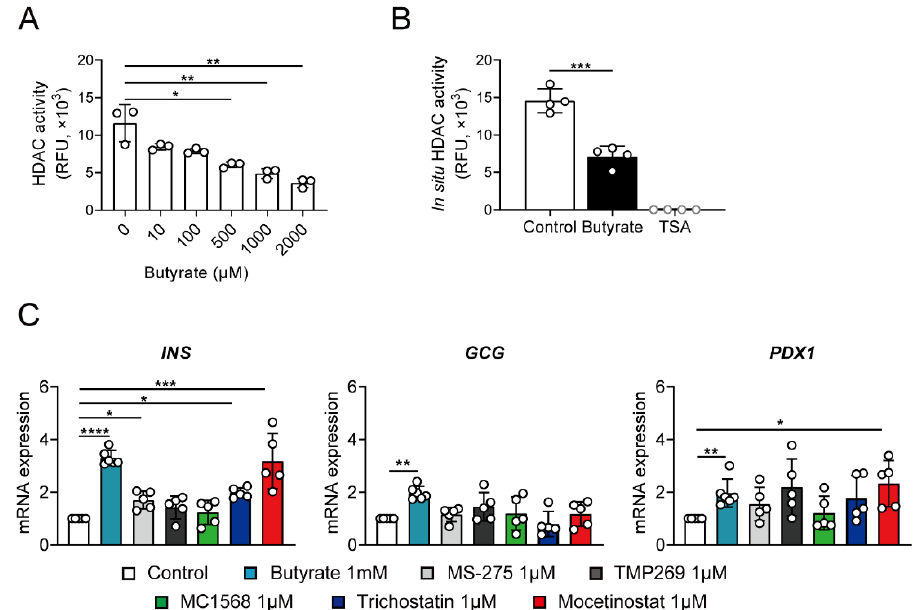
Figure 4. Inhibition of class I HDACs is involved in up-regulation of insulin gene expression. ( A ) Butyrate dose-dependently reduces in vitro HDAC enzyme activity in a HDAC fluorometric assay. ( B ) NPICCs were treated with 1000 µM butyrate and HDAC activity was measured by HDAC Activity Fluorometric Assay. Butyrate (1000 µM) and trichostatin A (TSA, 1 µM) significantly inhibited HDAC enzyme activity. ( C ) NPICCs were treated with different HDAC inhibitors for 6 days. TSA (1 µM) (class I and class II inhibitor), mocetinostat (1 µM) and MS275 (1 µM) (selective class I inhibitors) but not TMP269 (1 µM) or MC1568 (1 µM) (selective class II inhibitors) significantly increased insulin gene expression. NPICCs cultured in B-IC medium were used as controls. Data from three to five independent experiments are presented as mean ± SD. * p < 0.05, ** p < 0.01, *** p < 0.001, **** p < 0.0001 vs. control groups.